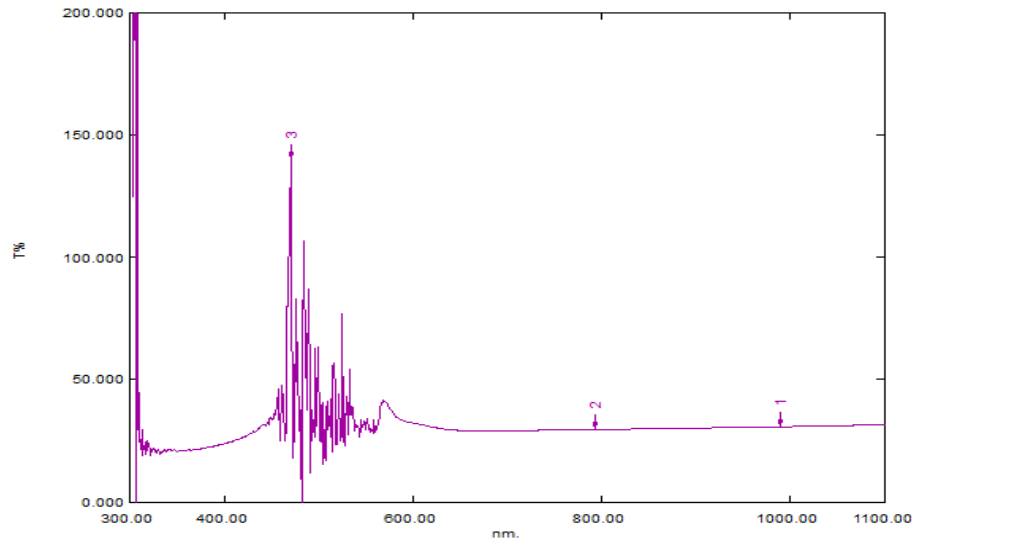
Fig.6: The UV ــ VIS absorption spectra of MWCNTs DI water Suspension at volume fraction 6 x10 -5